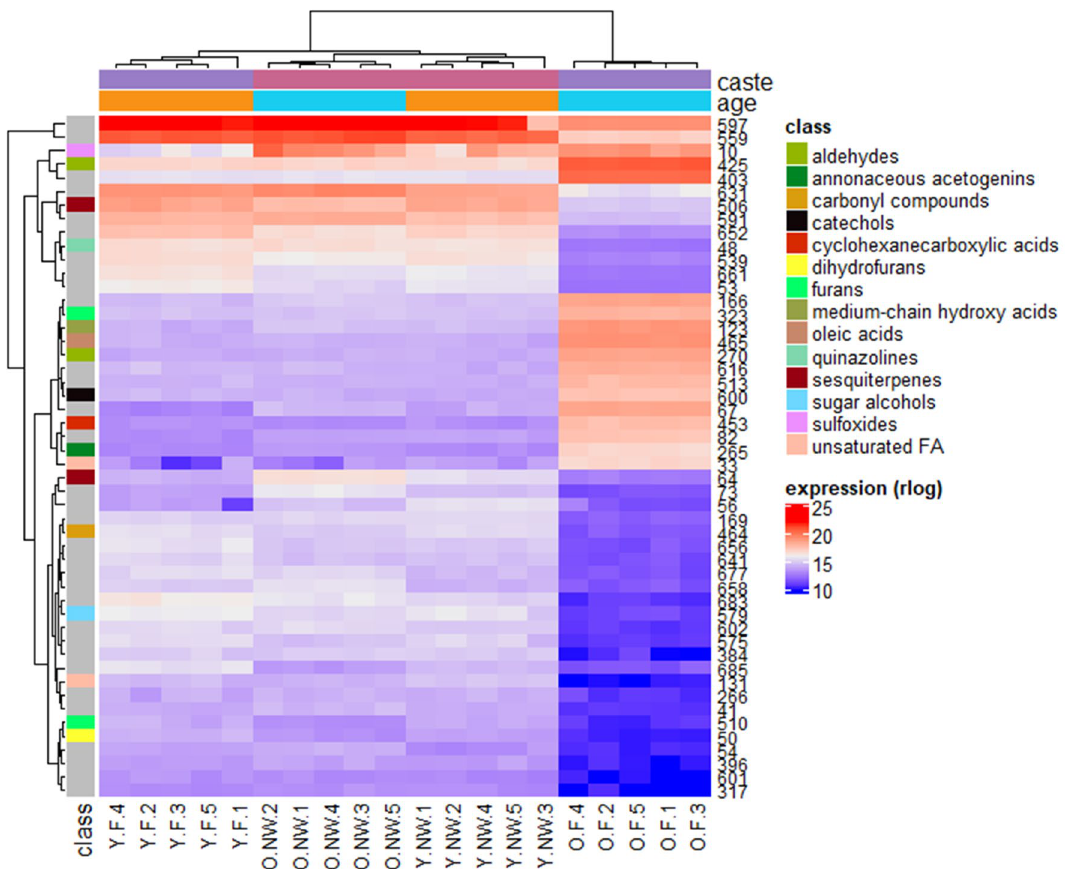
Figure 1. Heat map of the 50 most expressed metabolites amongst our four experimental groups of workers of Lasius niger . At the top, colours indicate the age (orange: young, light blue: old) and caste (pink: nest workers, purple: foragers). The left column indicates the metabolite class. Grey means that the metabolite class remains unknown. At the bottom are the sample identifiers (F: forager, NW: nest worker, Y: young, O: old). Metabolite IDs are given in the right-hand column. Correspondence between ID and name is indicated in every table provided. All metabolites presented here have an FDR < 0.05 and |fold-change| >